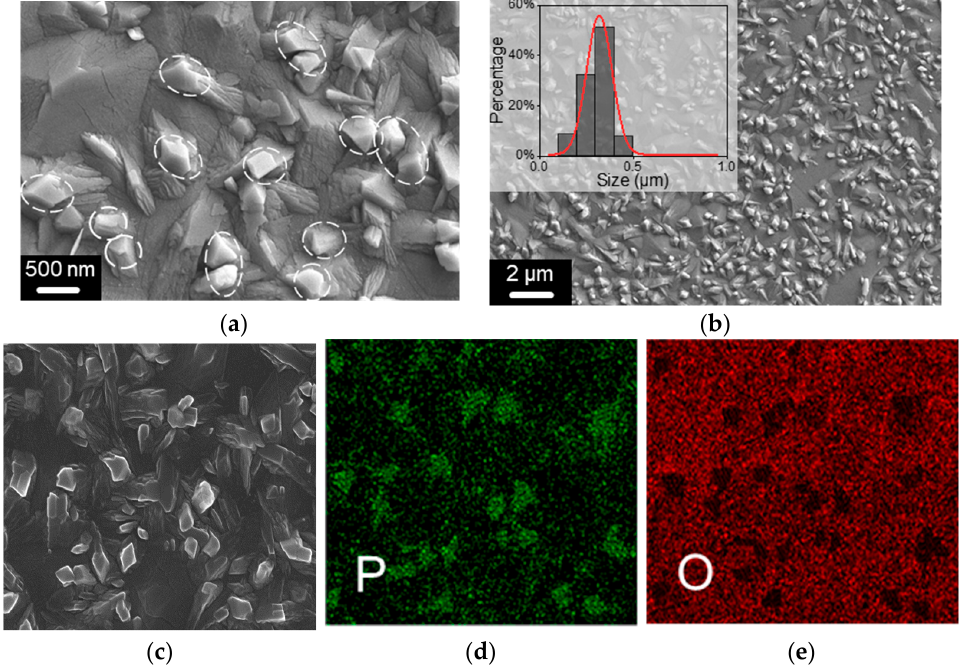
Figure 5. Microstructural and compositional properties of the BP thin film sensor: ( a ) SEM morphology; ( b ) SEM morphology with size distribution of grains; ( c ) Local morphology for elemental mapping; ( d ) Elemental distribution of P atoms; ( e ) Elemental distribution of O atoms.